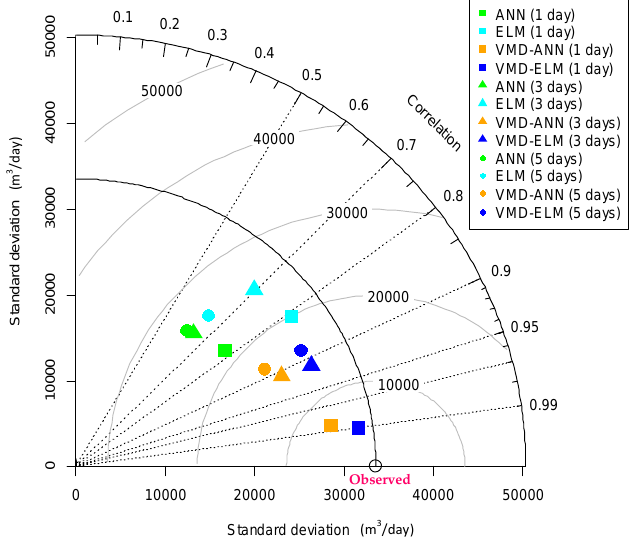
Figure 9. Taylor diagram for single and VMD-based forecasting models.